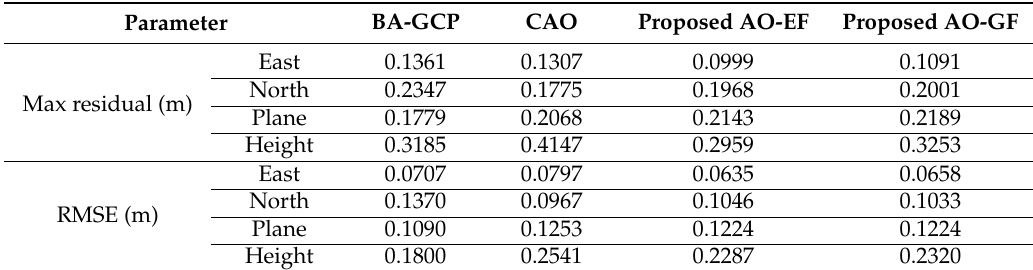
Table 4. The plane and height RMSE of the Village dataset obtained by the classical method and the proposed method.